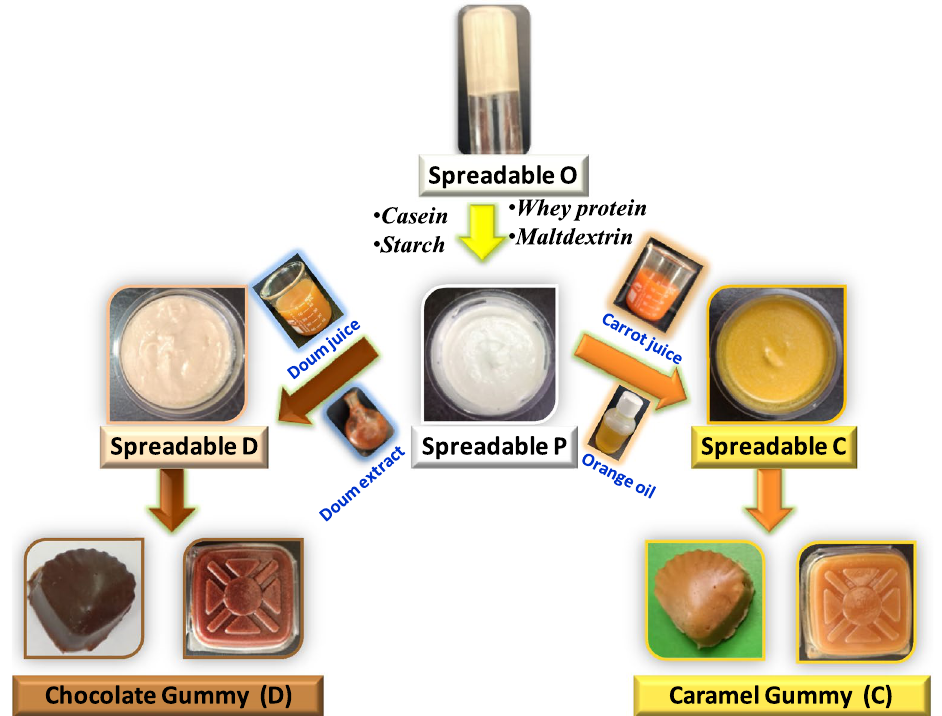
Figure 1. Schematic diagram for preparation of functional spreadable (O, P, D, and C) oleogels and their application in chocolate and caramel gummies.